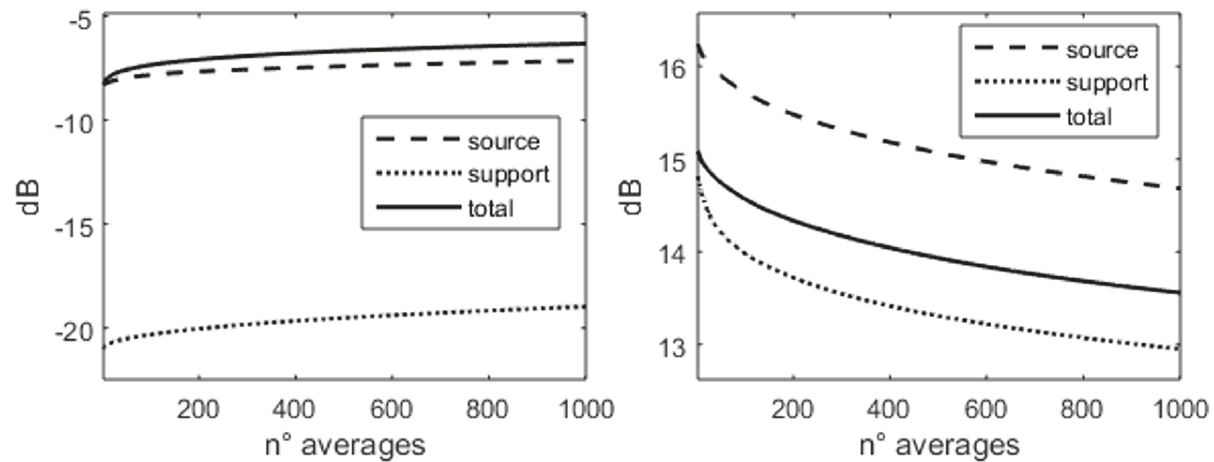
Figure 7: Average values of normalised levels of kinetic energy corresponding to parameters of Figure 6. Left: lowest levels; right: highest